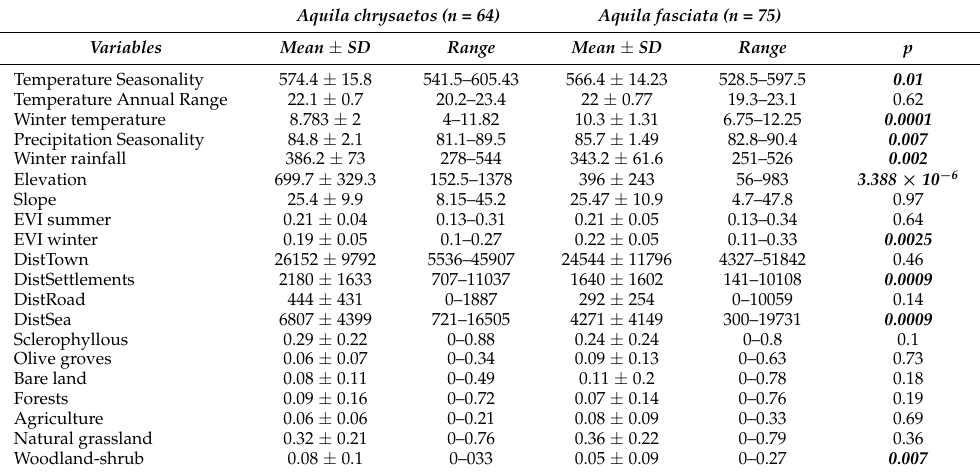
Table 2. Mean values ± SD and range (min-max) of environmental and habitat parameters of univariate analysis of Golden and the Bonelli’s eagle nest sites in Crete. ( Significant p values in bold and italic ). Aquila chrysaetos (n = 64) Aquila fasciata (n = 75)